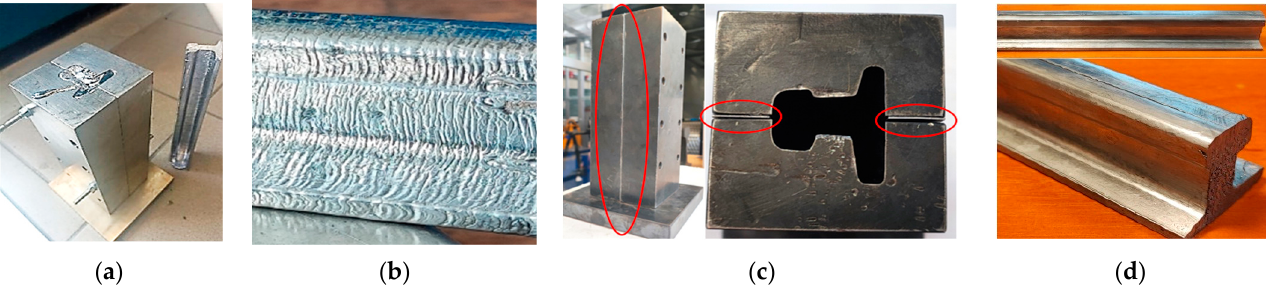
Figure 9. Images of: ( a ) the mold for casting a 60E1A6 needle rail from lead at ¼ scale, ( b ) a poor- quality needle rail surface after casting, ( c ) the mold with fixed spacers increasing the forging bay’s volume, ( d ) the rail after preliminary forming.